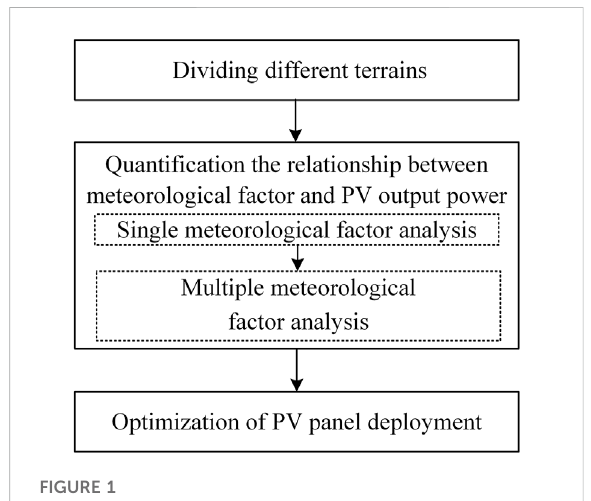
FIGURE 1 Three steps of the method for deployment of PV